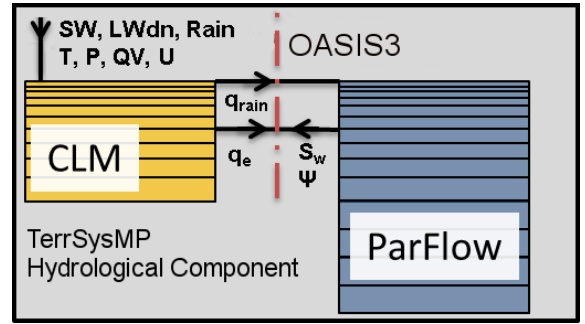
Figure 1. Schematic diagram of the hydrological component of the Terrestrial System Modeling Platform (TerrSysMP). OASIS3 is the driver of the component models for land surface (CLM) and sub- surface (ParFlow). The configuration file for OASIS3 prescribes the end-point data exchange between the component models in a se- quential manner. The variables exchanged between the two models are relative saturation ( S w ), soil pressure head ( (cid:57) ), top soil mois- ture flux ( q rain ), soil evapotranspiration ( q e ), air temperature ( T ), wind speed ( U ), specific humidity (QV), total precipitation (Rain), pressure ( P ), and incoming shortwave (SW) and longwave